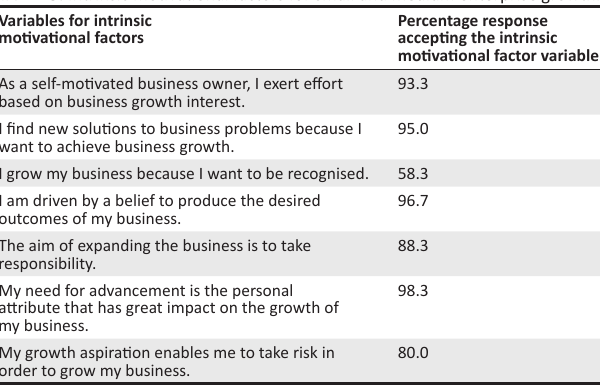
TABLE 5: Intrinsic motivational factors for small and medium enterprise growth. Variables for intrinsic motivational